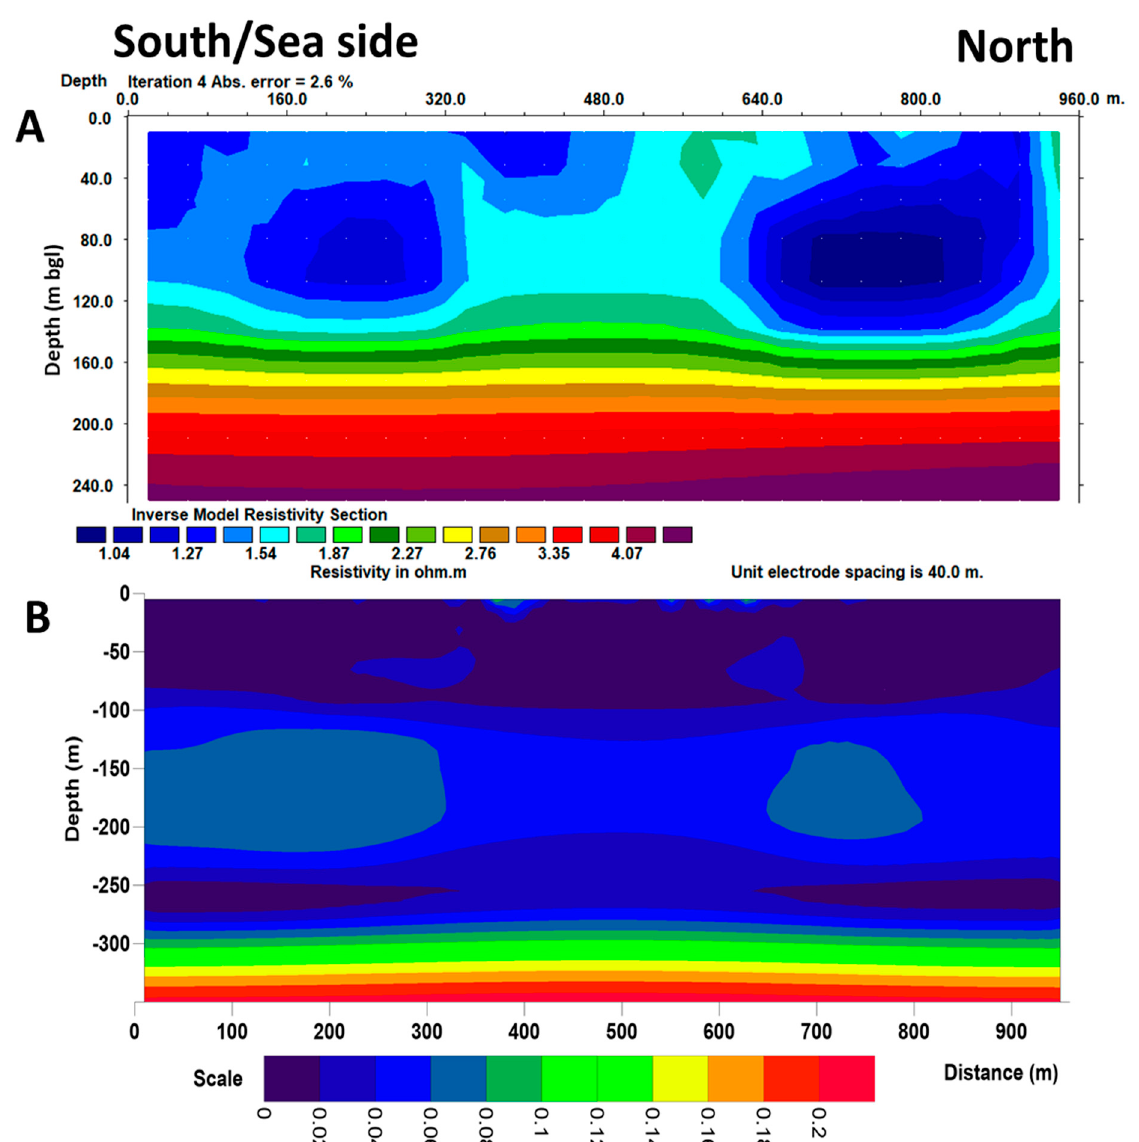
Figure 6. Interpreted inverse 2-D resistivity model section near the shoreline of the Bay of Bengal ( A ). Bottom image is a DOI map ( B ). Profile lies below the DOI index of 0.1, indicating well-resolved regions controlled by the data.